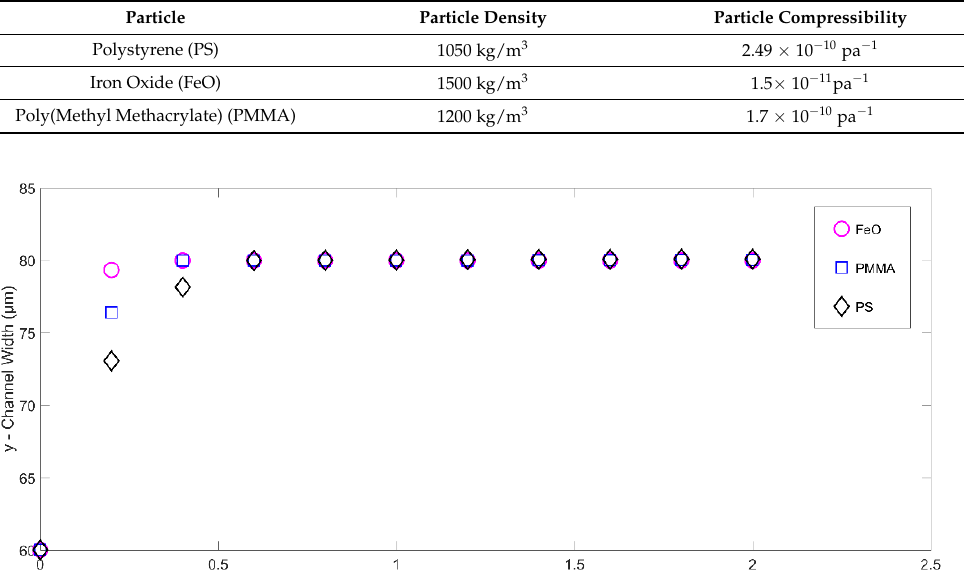
Table 2. Particles used in the numerical model to study the trajectories with varying density and compressibility values. The properties of the particles are taken from Ref. [37].